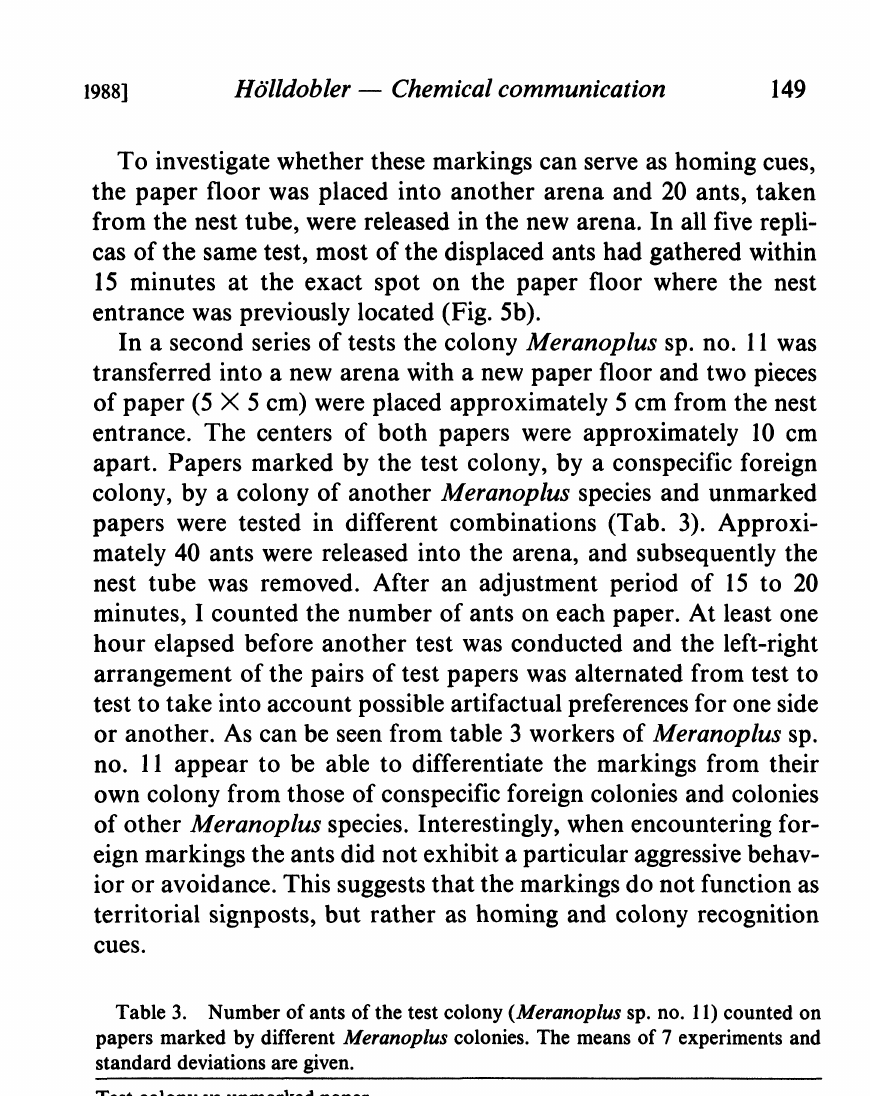
Table 3. Number of ants of the test colony (Meranoplus sp. no. 11) counted on papers marked by different Meranoplus colonies. The means of 7 experiments and standard deviations are